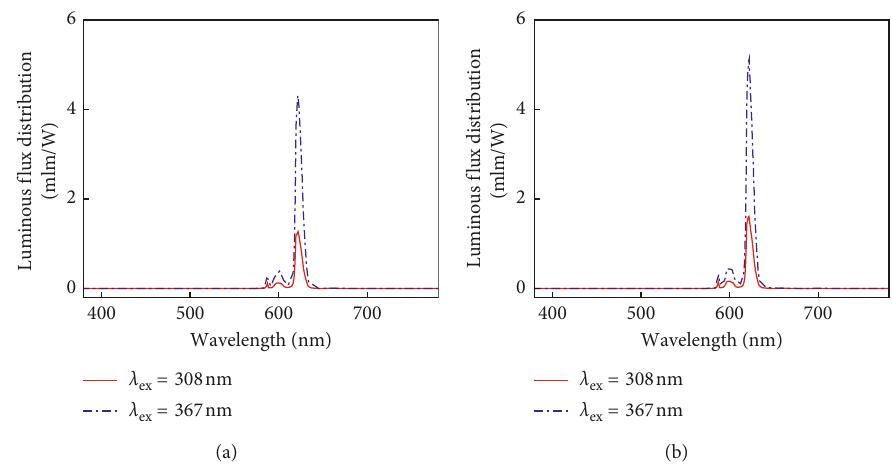
Figure 10: Luminous flux distributions of luminescence of Eu(BA)(TTA) 2 /PVP (a) and Eu(BA)(TTA) 2 Phen/PVP (b) under 308nm and 367nm excitations. Table 2: Total luminous fluxes of Eu(BA)(TTA) 2 /PVP and Eu(BA)(TTA) 2 Phen/PVP films under 308 and 367nm UV-LEDs excitations. Samples